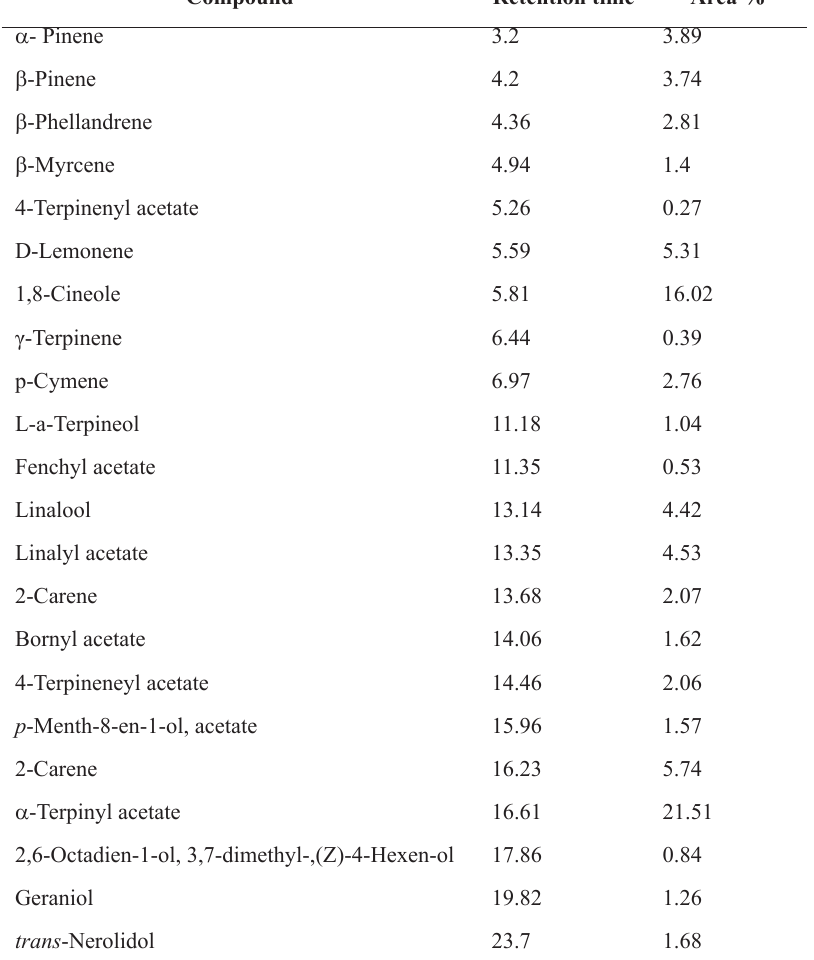
Table 4: Principal constituents of cardamom oil and their relative percentages of total chromatogram area. Compound Retention time Area % a -